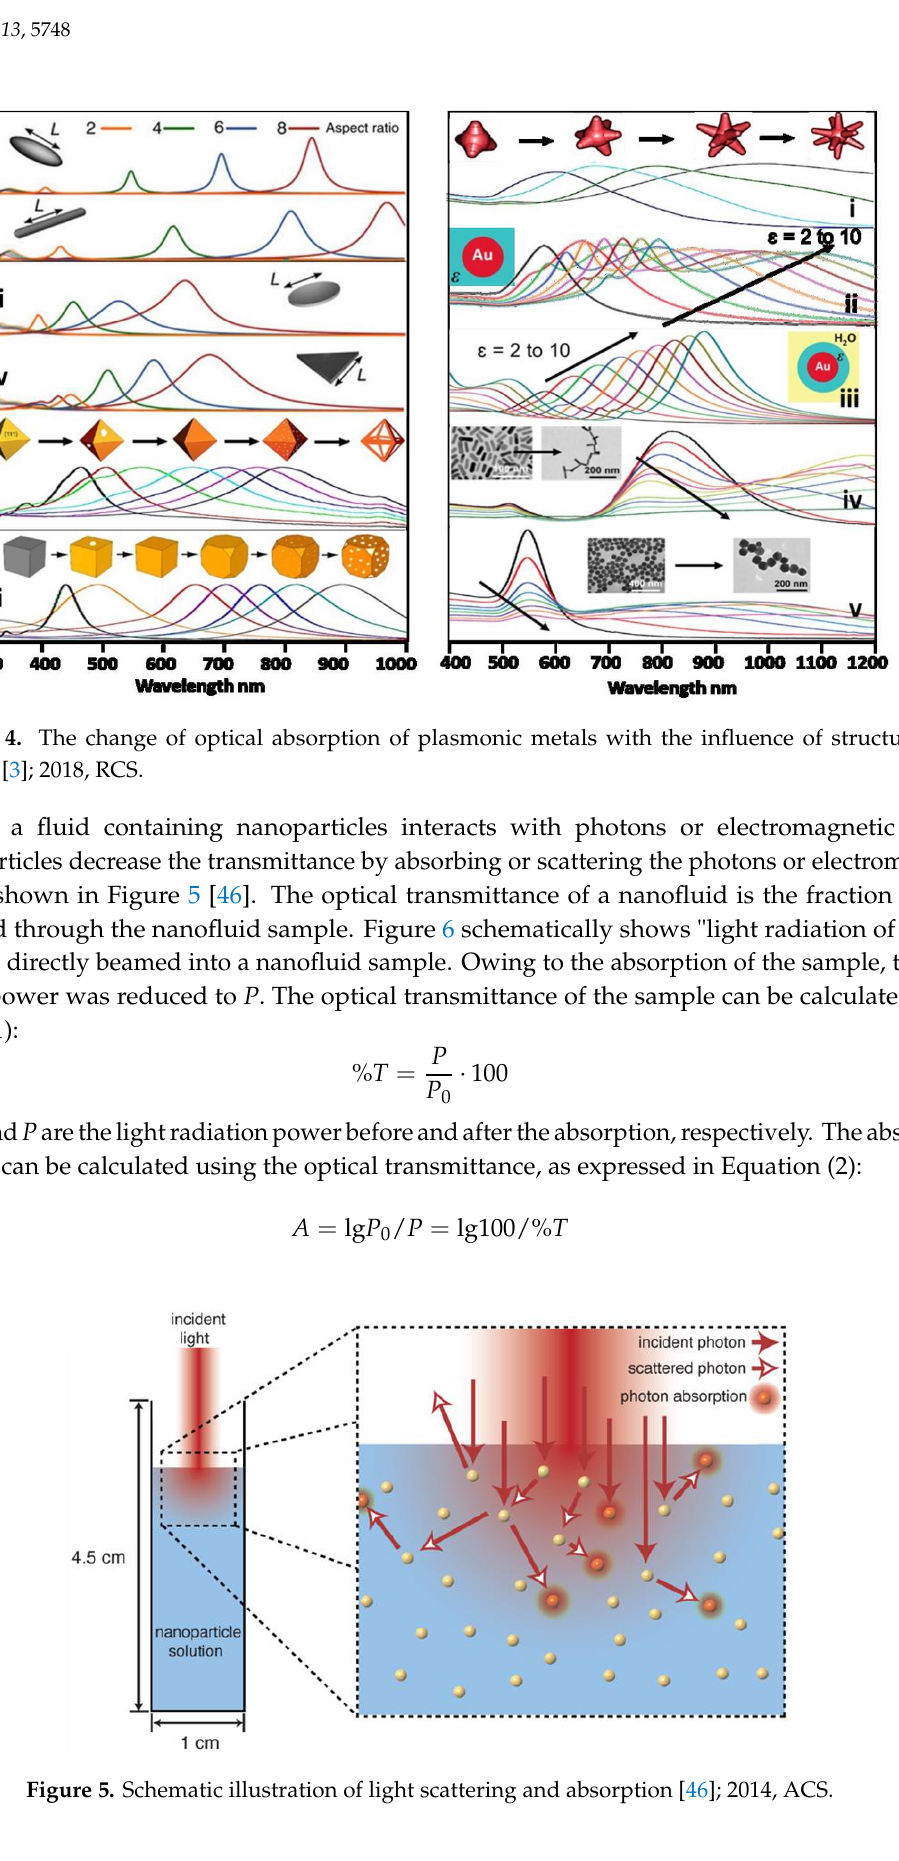
Figure 6. Schematic of light transmittance and absorbance. Taylor et al. [47] reported that water as a base fluid is a good absorber at long wavelengths; it is also a good emitter at the same wavelengths. Hence, additional nanoparticles in the base fluid (water) could be the ideal compensation for the decrease in emission at longer wavelengths. Furthermore, the results of their work suggest that light scattering is negligible when the particle size is less than 50 nm. However, a measurable amount of light can be scattered if the particle size is >50 nm or a particle cluster exists. They also reported that the incoming solar radiation is absorbed by the thin top layer of the nanofluid at an excessive nanoparticle concentration, leading to thermal loss to ambient air. On the other hand, if the nanofluid concentration is too low, the nanofluid cannot absorb an appropriate amount of solar energy. As shown in Figure 7, Fang et al. [48] reported that the colors of CuO, ZnO, and CuO/ZnO nanofluids became darker as the nanofluid concentration increased. Moreover, the light absorption of the nanofluid increased as the color became darker. Vijayanandan et al. [42] studied the optical and photothermal energy conversion of a Co 3 O 4 nanofluid synthesized by the endophytic fungus Aspergillus nidulans. They reported that nanoparticles with a diameter smaller than the incident wavelengths interacted with the light irradiation through Rayleigh scattering.